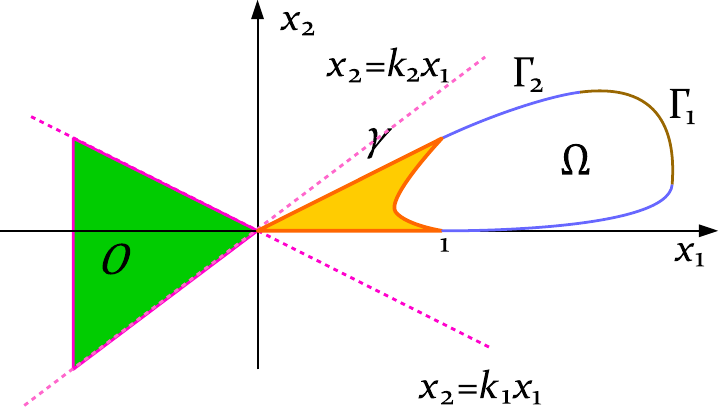
Figure 2. Geometry of the problem for the composite body with the volume rigid